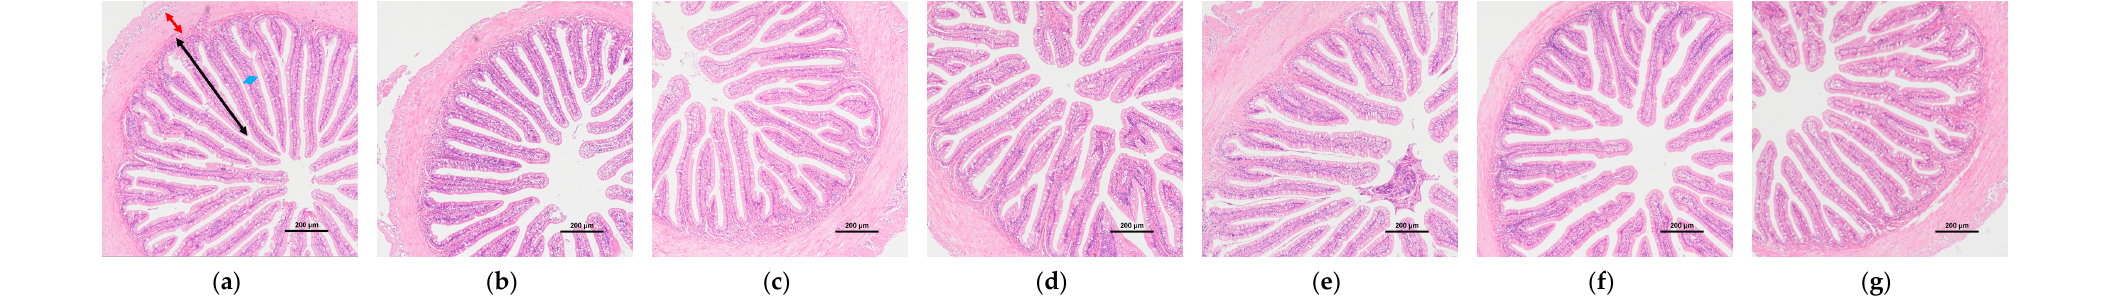
Figure 3. Effect of dietary histamine content on the hindgut histomorphology of the hybrid grouper. ( a ) indicates H0 group; ( b ) indicates H3 group; ( c ) indicates H6 group; ( d ) indicates H12 group; ( e ) indicates H24 group; ( f ) indicates H48 group; and ( g ) indicates H96 group. Black arrows: fold height ( μ m); blue arrows: fold width ( μ m); red arrows: muscular thickness ( μ m). The magnification was ×100, and the minimum scale (lower right) was 200 μ m.